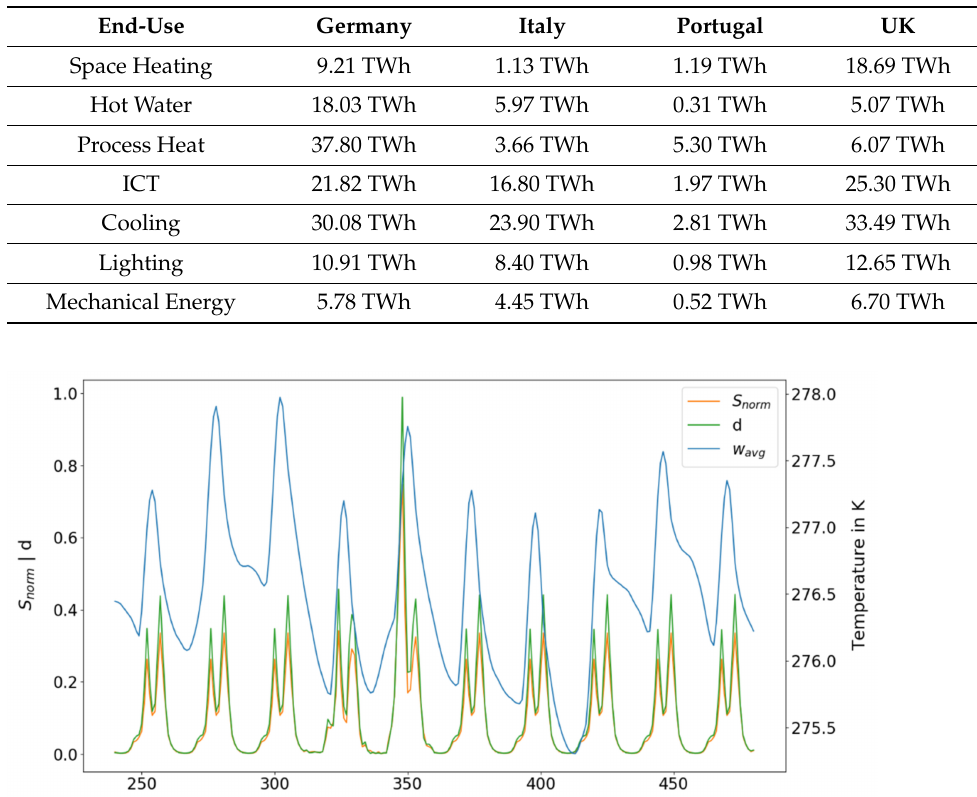
Table A2. Annual consumption per end-use for the countries presented in this work. We use annual consumption per end-use to scale the normalized profiles of our methodology to real load curves.